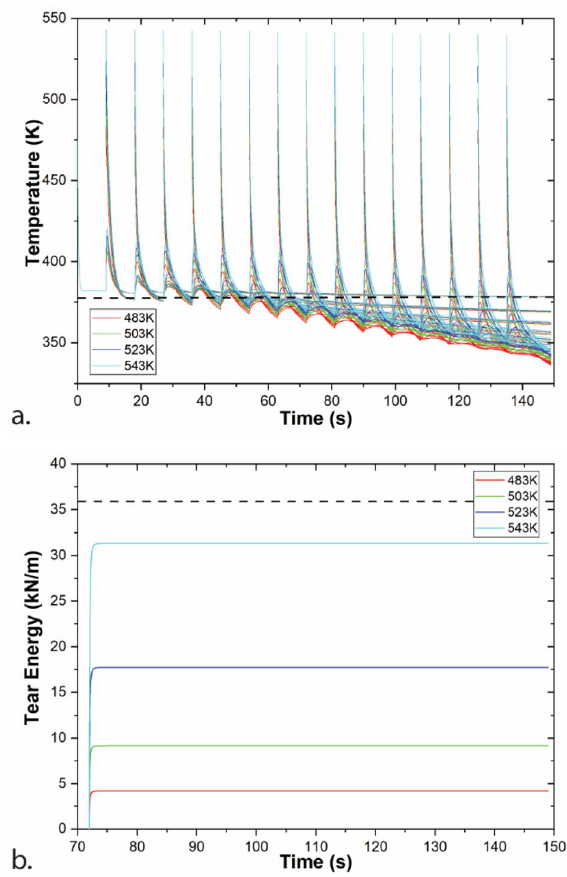
Figure 2. Modeling of a single-road width wall printing at a range of T ext with v print = 30 mm/s, h = 0.3 mm. ( a ) Temperature of all layers at four values of T ext ; ( b ) tear energies based on the thermal profiles for the weld between layers 8 and 9 for four values of T ext